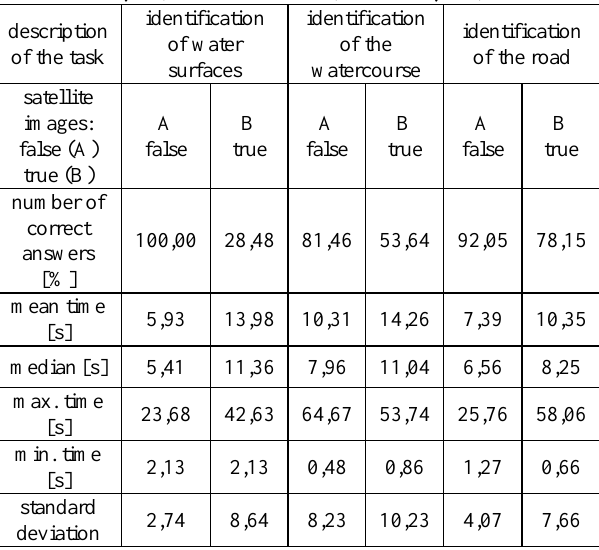
Table 5. Basic descriptive characteristics of the tasks of